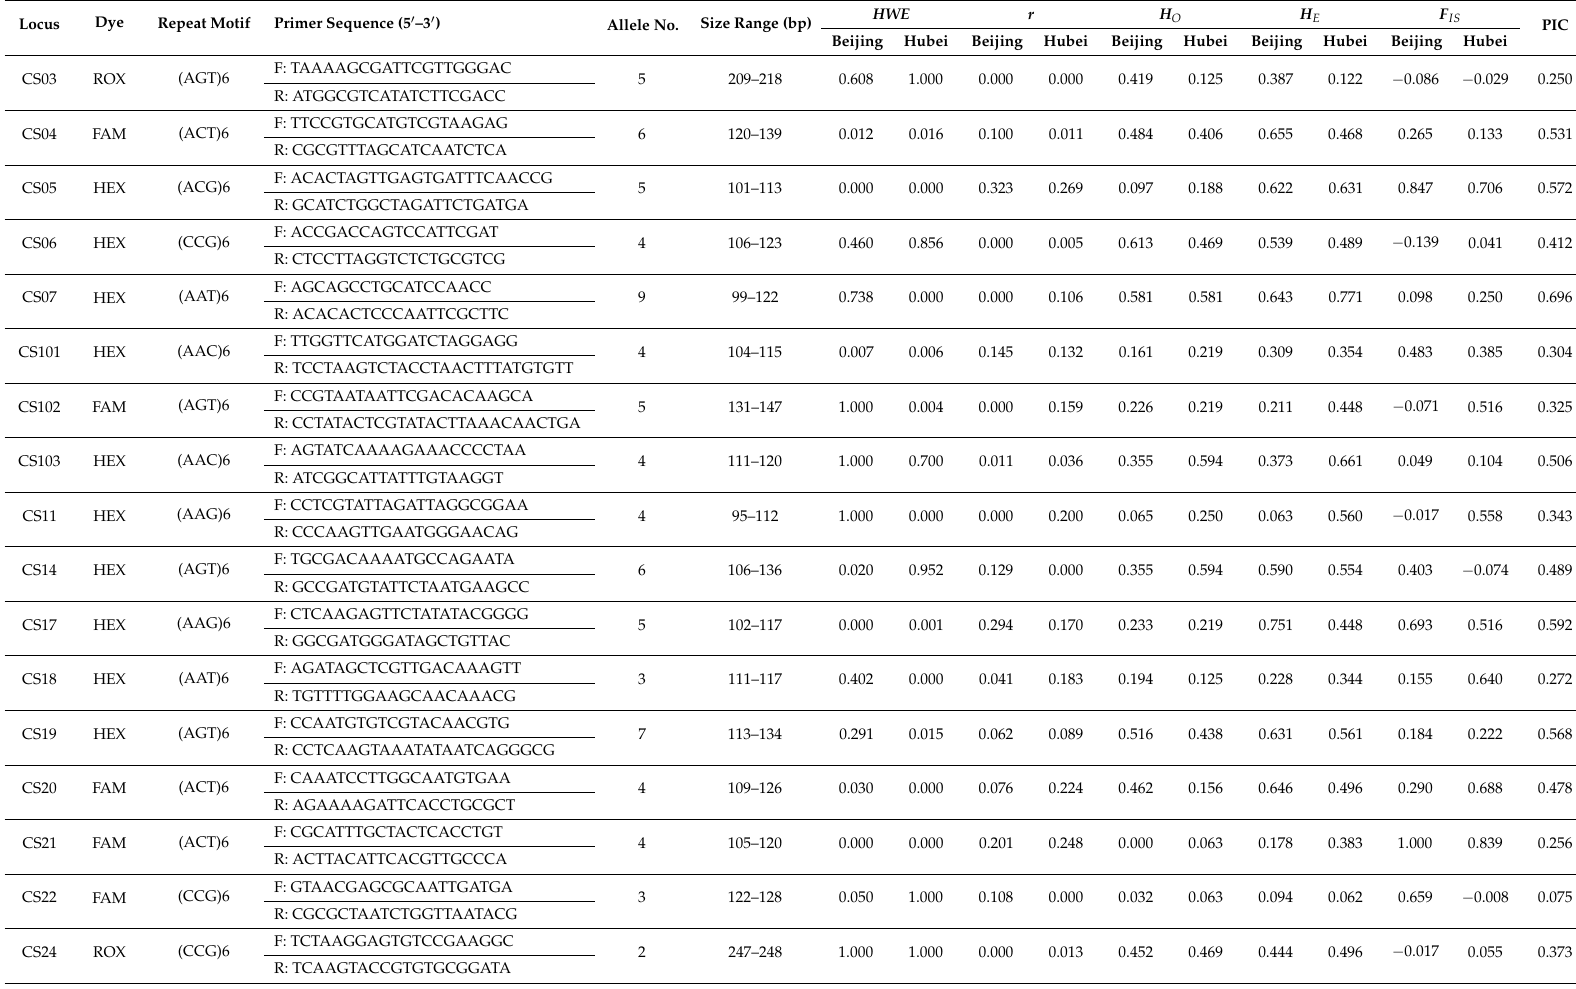
Table 2. Characteristics of 35 microsatellite loci validated in 63 individuals of Carposina